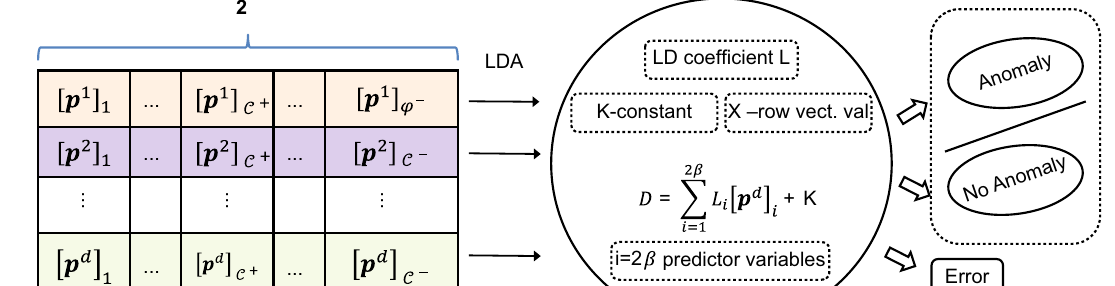
Fig. 4 (Algorithm design - 3.part